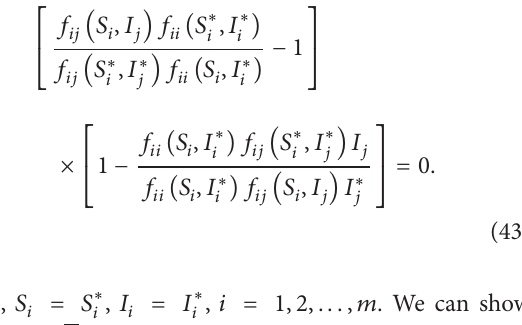
Figure 3: Trajectories of 𝑆 1 (𝑡),𝐼 1 (𝑡),𝑆 2 (𝑡) , and 𝐼 2 (𝑡) for 𝑅 0 = 1.67355 > 1 , and 𝑃 0.0765909, 0.0765909, 4.4678) is globally stable. 𝑆 1 (𝑡), 𝑆 2 (𝑡), 𝐼 1 (𝑡) , and 𝐼 2 (𝑡) versus 𝑡 are illustrated by (a), (b), (c), and (d). Initial values are